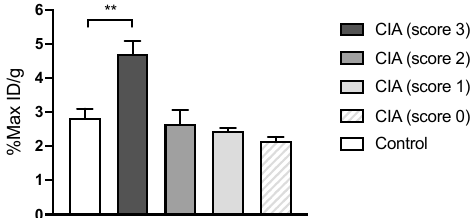
Figure 2. In vivo quantification of 64 Cu-DOTATATE uptake in collagen-induced arthritis (CIA) mice ( n = 7) and controls ( n = 4). Data are presented as maximal percentage of injected dose per gram tissue (%Max ID/g) in each joint acquired 3 h p.i. Data are presented as mean ± SEM. The significance level is indicated by asterisks (*). p = 0.0032 (**).